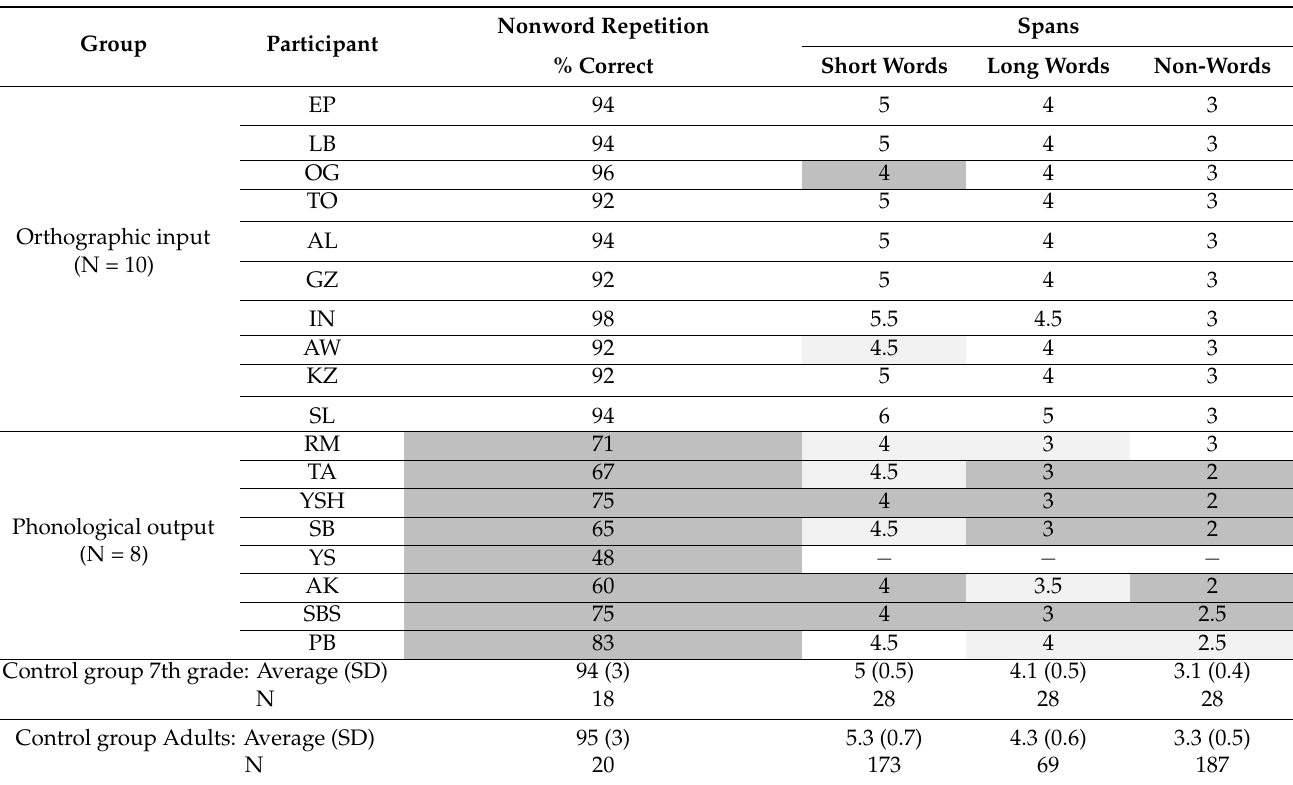
Table 2. Performance in the BLIP nonword repetition test (%correctly repeated) and in the FriGvi phonological working memory serial recall tests